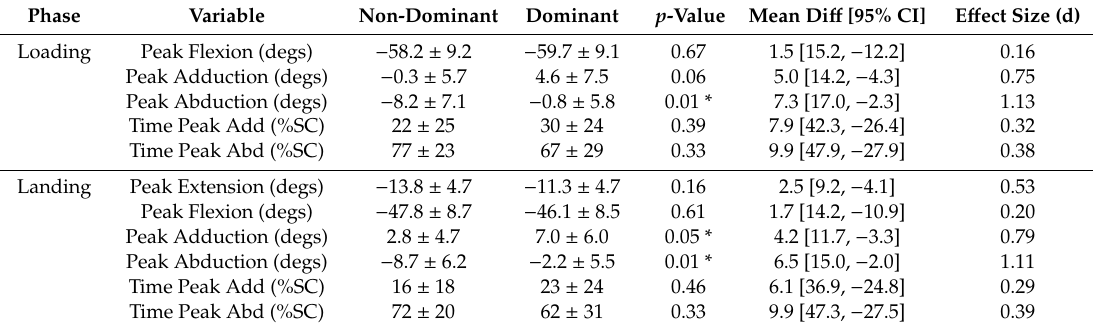
Table 2. Knee motion for both loading and landing phases. Abd—Abduction;